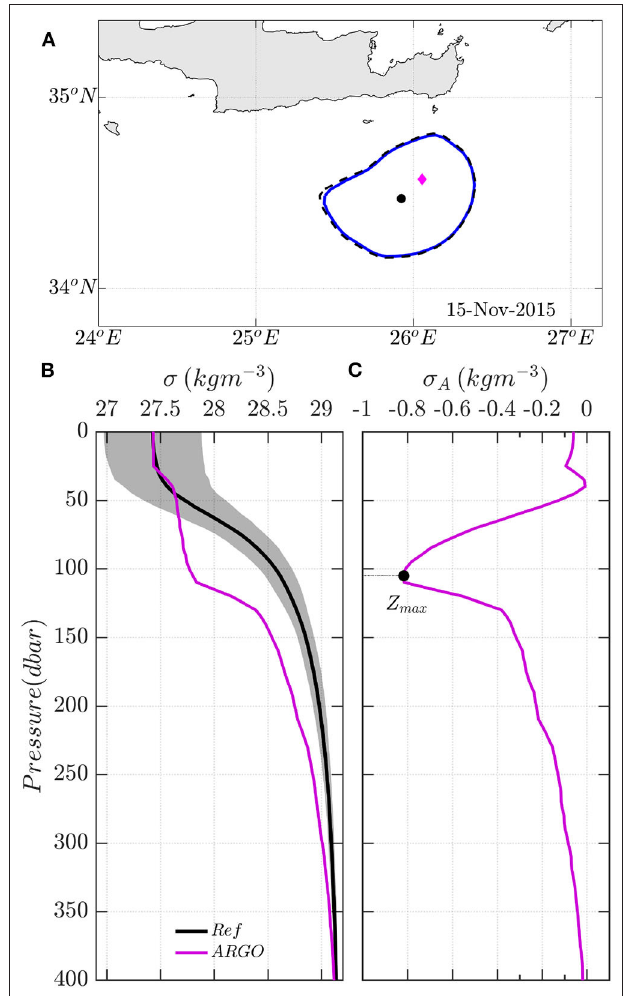
FIGURE 2 | (A) Position of the O_IE15 in November 2015. The eddy characteristic and last contour are illustrated with the blue solid and black dashed lines. The position of an Argo float trapped inside the eddy is shown with the magenta diamond. Vertical (B) density σ and (C) density anomaly σ A profile of the Argo float trapped inside the O_IE15 (magenta color). The black line shows the mean climatological profile as computed by Argo profiles that are detected outside of